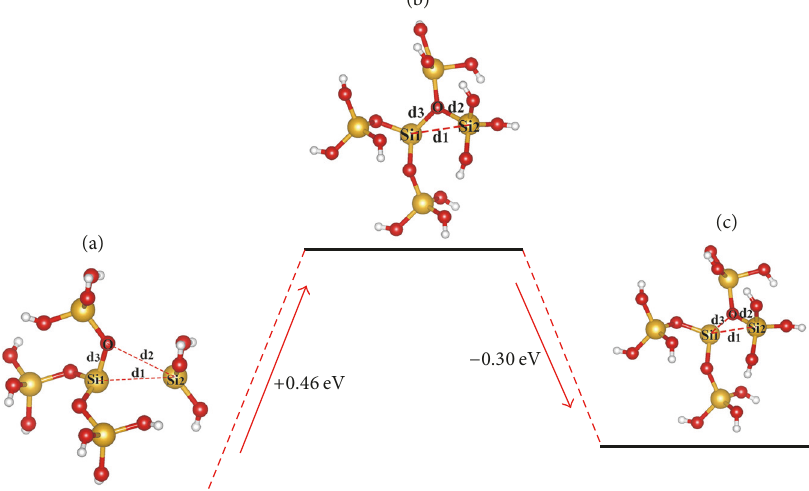
Figure 8: Schematic illustration of the proposed interconversion mechanism from ODC(I) defect into ODC(II) defect in the lowest triplet (𝑇 ) excited state. The red arrows stand for transformation of preexisting point defects and recombinations. (a) Optimized geometry of the 1 Si 5 O 15 H 12 cluster with ODC(I), 𝑑1 = 3.02 ˚ A, 𝑑2 = 3.05 ˚ A, and 𝑑3 = 1.65 ˚ A. (b) The transition state geometry of the Si 5 O 15 H 12 cluster, 𝑑1 = 3.13 ˚A, 𝑑2 = 1.86 ˚A, and 𝑑3 = 1.80 ˚A. (c) Optimized geometry of the Si 𝑑3 = 1.91